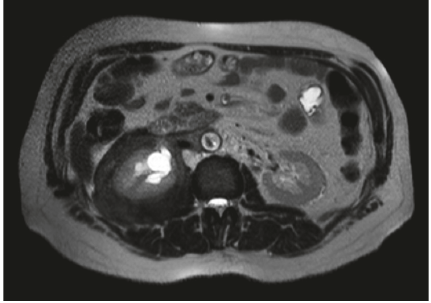
Figure 2: Preoperative magnetic resonance imaging (MRI) scan showing a right renal